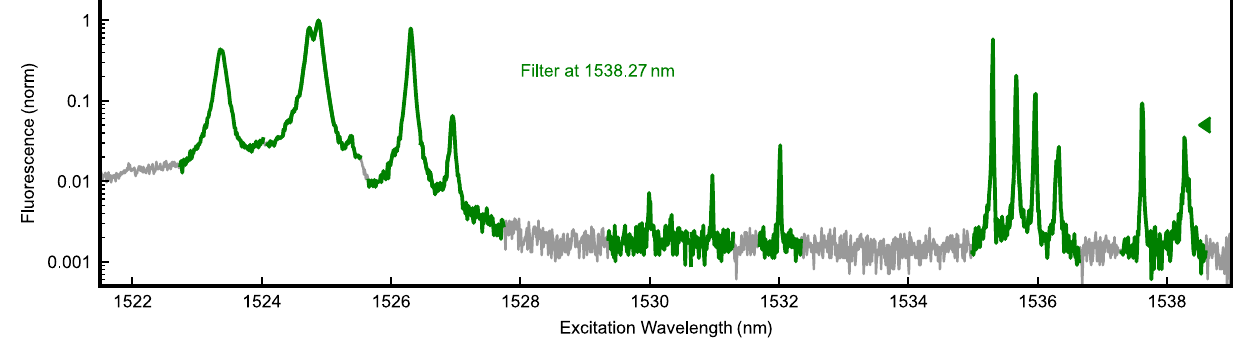
FIG. 12. Excited-state CF levels of site P. Site P is attributed to erbium precipitates as it shows 14 CF levels in the I 13 = 2 manifold — twice the number expected for a single erbium site in the absence of a magnetic field. As the smaller CF splitting of this site cannot be resolved well in Fig. 2(b), this figure shows the data over a smaller wavelength spread. While we can resolve the I 13 = 2 levels well by scanning the narrow-linewidth laser, not all I 15 = 2 levels are resolved because of the finite 0.11 nm bandwidth of the available wavelength filter.